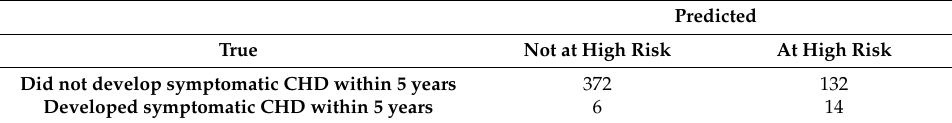
Table 3. The confusion matrix of the integrated genetic-epigenetic ensemble of 27 models on the test dataset consisting of 524 individuals for predicting the five-year risk of developing symptomatic CHD. Predicted True Not at High Risk At High Risk Did not develop symptomatic CHD within 5 years 372 132 Developed symptomatic CHD within 5 years 6